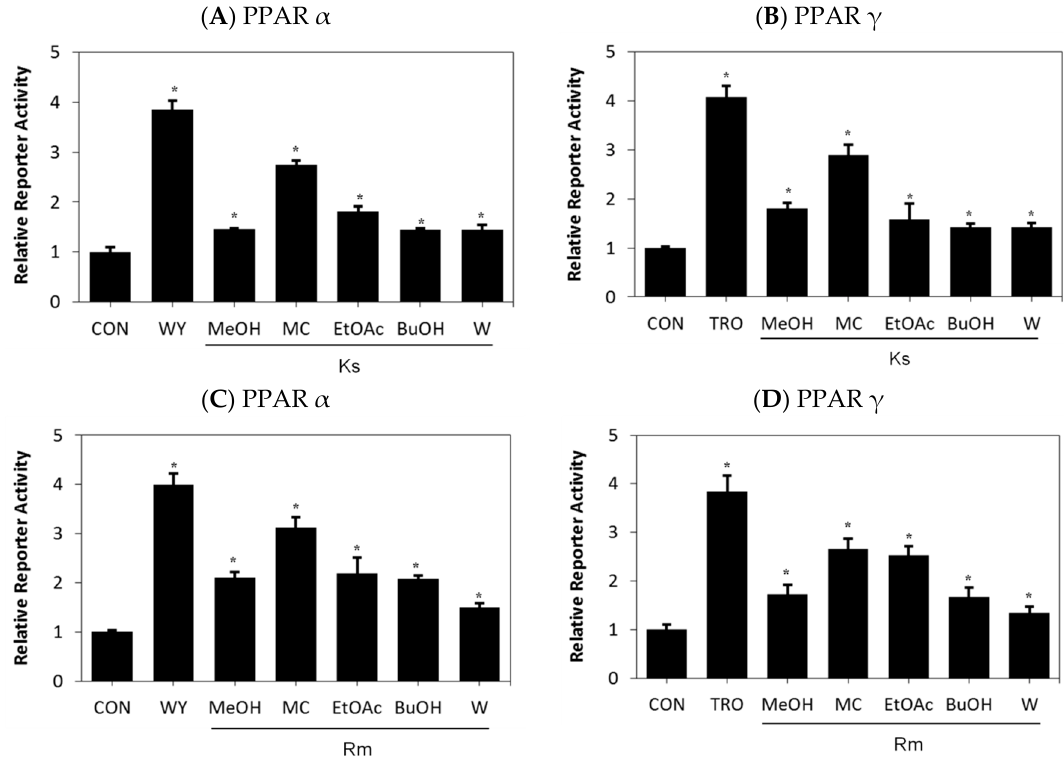
Figure 1. Peroxisome proliferator-activated receptor (PPAR) transcriptional activity after treatment with extracts of Kochia scoparia (Ks) or Rosa multiflora (Rm) in CV-1 cells, a line of monkey kidney cells. CV-1 cells were transfected with human PPAR α ( A , C ) or PPAR γ ( B , D ) expression vectors, the peroxisome proliferator response element (PPRE)–luciferase reporter construct, and the pRL-SV40 vector. After transfection, cells were treated with various extracts and fractions of Ks ( A , B ) or Rm ( C , D ) for 24 h and the relative transcriptional activities were analyzed. WY: WY14643 acting primarily as an activator of PPAR α , TRO: Troglitazone acting as a ligand for both PPAR α and more strongly for PPAR γ , MeOH: Methanol extract, MC: Methylene chloride, EtOAc: Ethyl acetate, BuOH: Butanol, W: water. Each bar represents the mean ± SEM of duplicates. * p < 0.05 vs control.